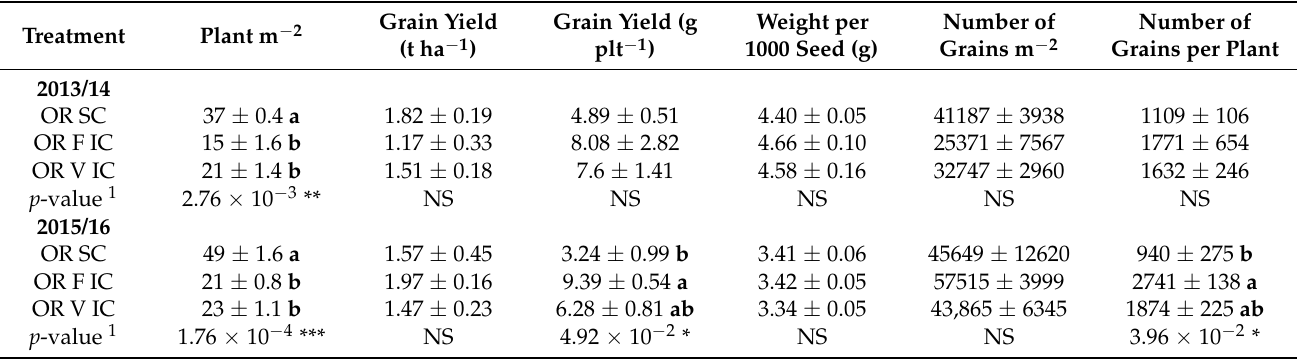
Table 6. The grain yield components of oilseed rape grown as either a sole crop (OR SC) or inter- cropped with faba bean (OR F IC) or common vetch (OR V IC) in 2013/14 and 2015/16. Values are mean ( n = 3) ± standard